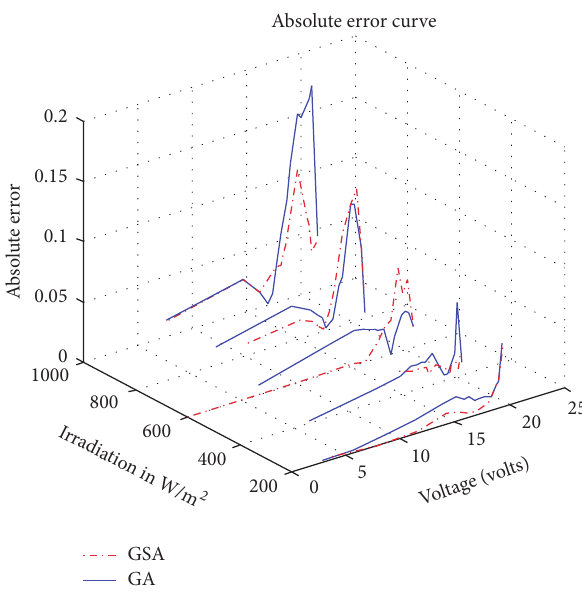
Figure 8: Error graph for Shell